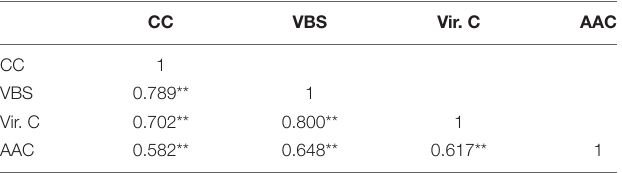
TABLE 2 | Pearson’s correlation coefficients between the scales contained in the Virtual Learning Environments Questionnaire.